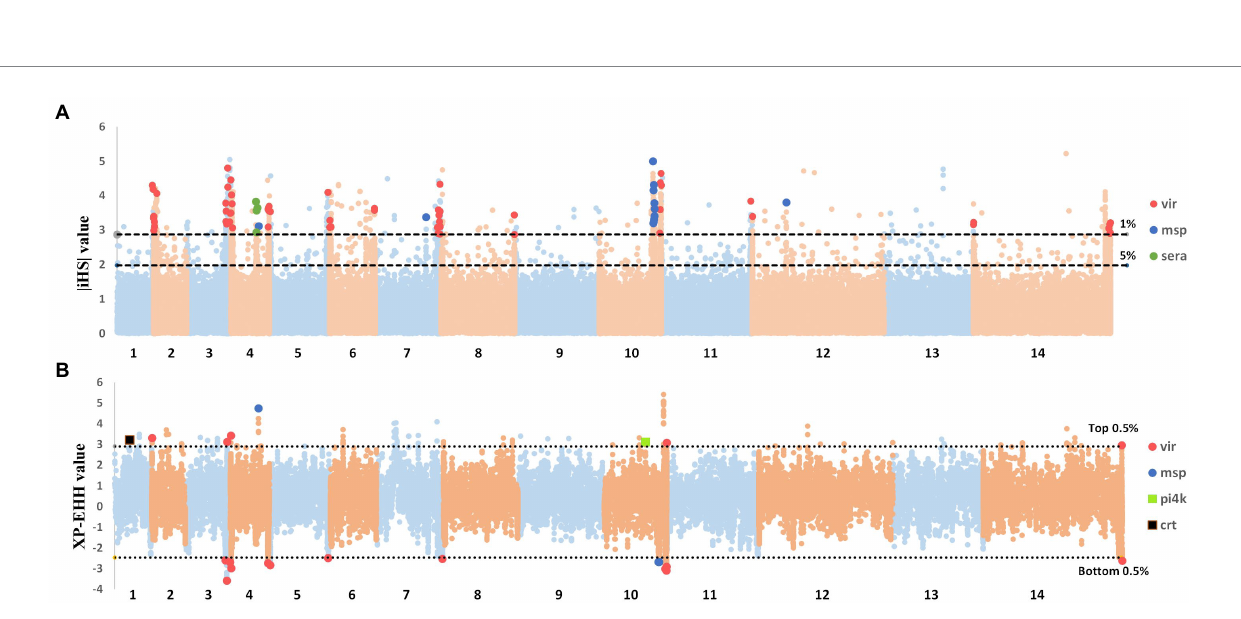
FIGURE 4 Genome-wide scans to identify regions with extended homozygosity using haplotype-based detecting positive selection. (A) Genome-wide scan of standardized |iHS| for Plasmodium vivax SNPs with a minor allele frequency of at least 5% in inland samples. Dashed lines indicate the top 1% of |iHS| values (|iHS| score of >2.8). (B) Genome-wide scan of standardized XP-EHH for P. vivax SNPs with a minor allele frequency of at least 5% in inland samples. Using CMB isolates as the reference population. Dashed lines indicate the top 1% of XP-EHH values (±0.5%, XP-EHH score of >0.78 or < − 0.24 in CMB-China).